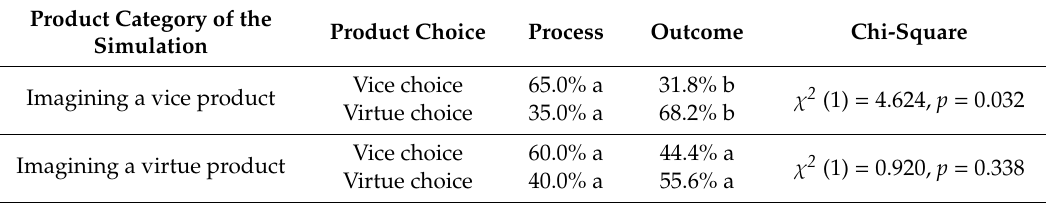
Table 2. Choice frequency (%) of participants’ choices in each mental simulation, in which participants imagined a vice product (chocolate cookies) and a virtue product (banana). Di ff erent letters across columns represent significant di ff erences between mental simulation type.